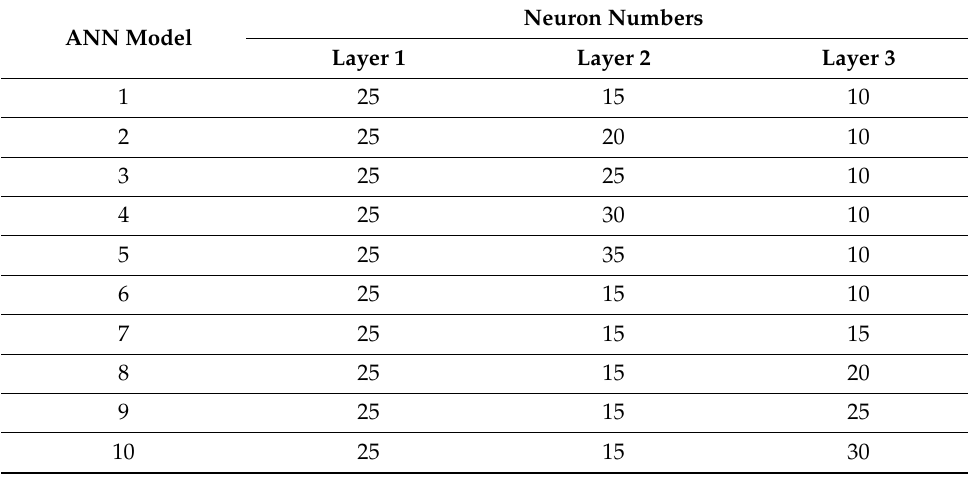
Table 6. ANN architecture of models with variant neuron numbers.